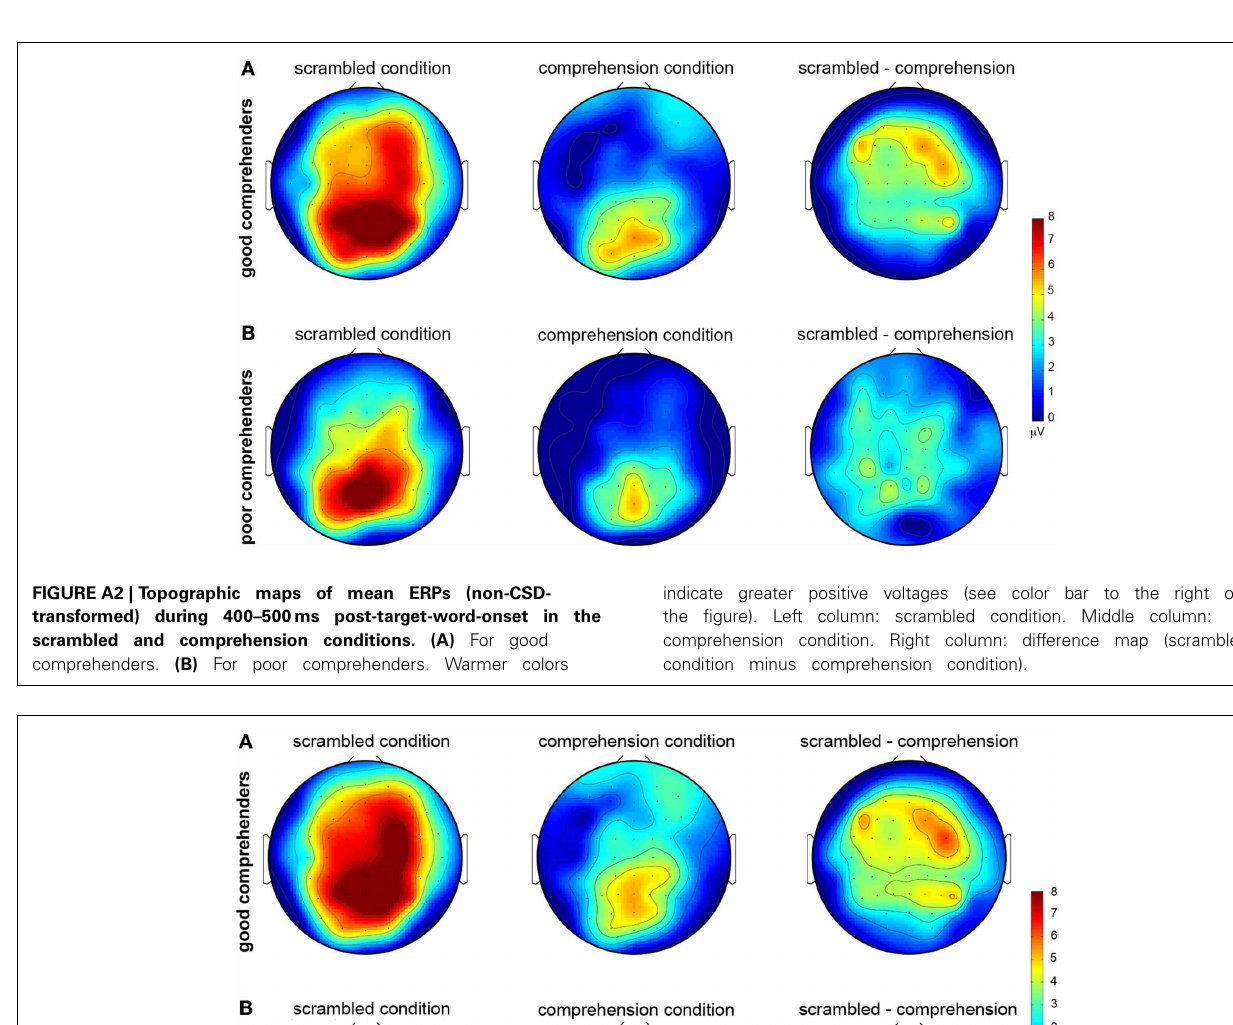
FIGURE A3 | Topographic maps of mean P300 difference waves (non-CSD-transformed ERPs to targets minus those to non-targets) during 400–500ms in the scrambled and comprehension conditions. (A) For good comprehenders. (B) For poor comprehenders. Warmer colors